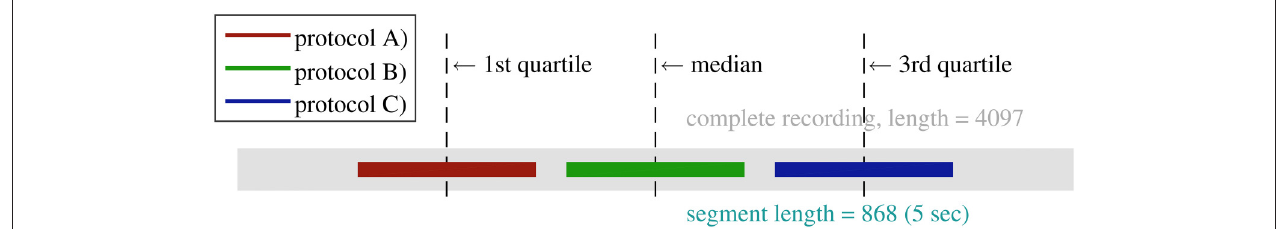
FIGURE 2 | Schematic diagram of the three 5s segment selection protocols.